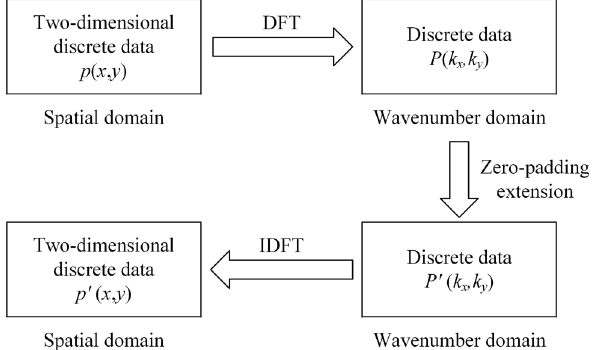
Figure 1. Block diagram of smoothing process for two-dimensional discrete data.